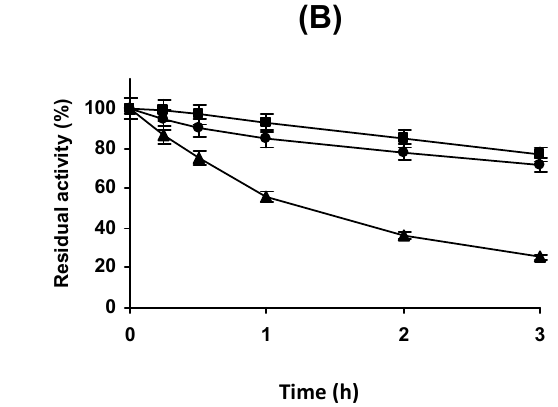
Figure 2. Effect of the buffer nature on the stability of free r Aae UPO. Inactivation was performed at pH 7.0 and ( A ) 50 or ( B ) 57 °C. Other specifications can be found in the Methods section. Full squares: 50 mM HEPES; full circles: 50 mM Tris; full triangles: 50 mM sodium phosphate.